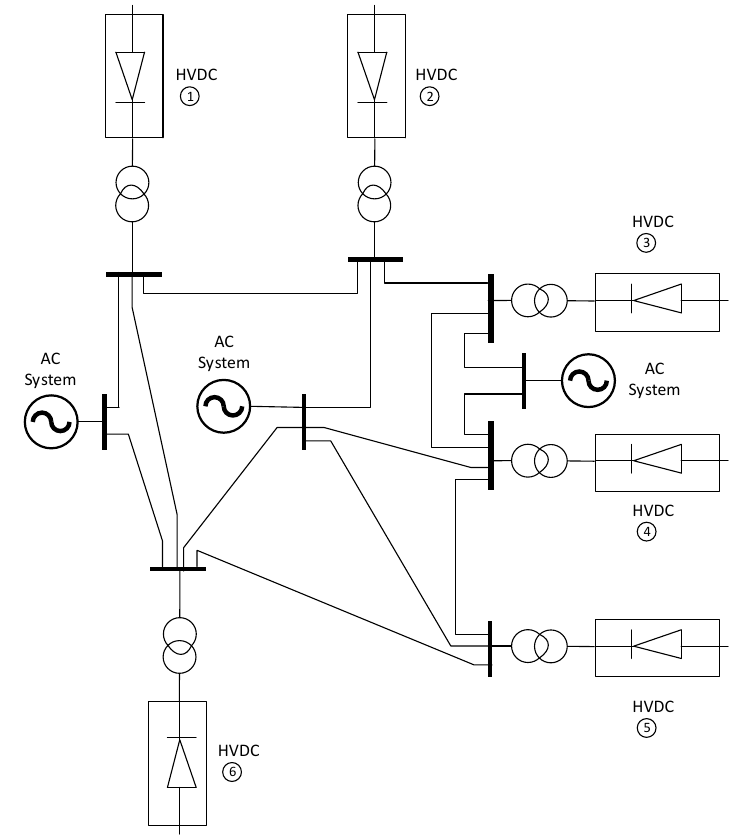
Figure 3. Mesh-type multi-infeed HVDC system.